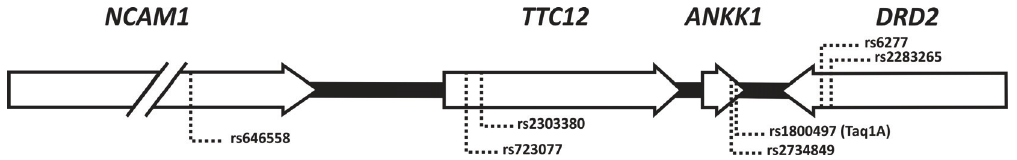
Figure S1- The NTAD cluster in the human genome, showing the single nucleotide polymorphisms (SNPs) included in this study. The sizes of the four genes are 317 kb, 69 kb, 13 kb and 66 kb, from left to right. Only DRD2 is positioned in the reverse strand (arrow pointing to the